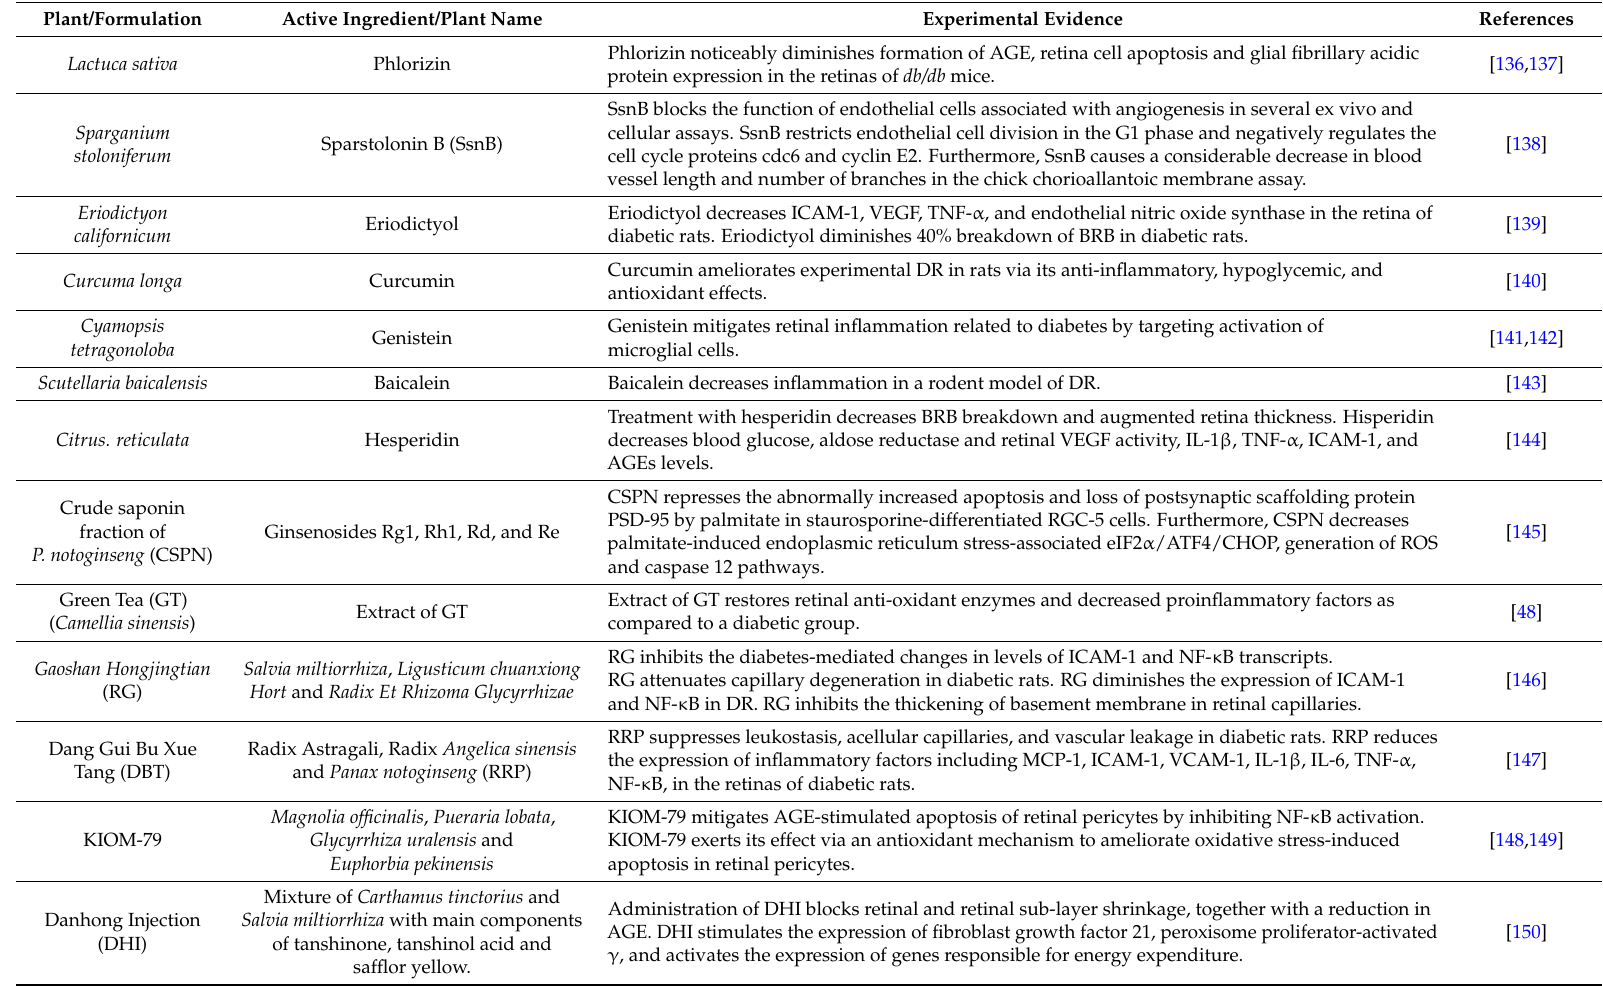
Table 1. Evidence-based Traditional Herbal Plant/Formulations in Diabetic